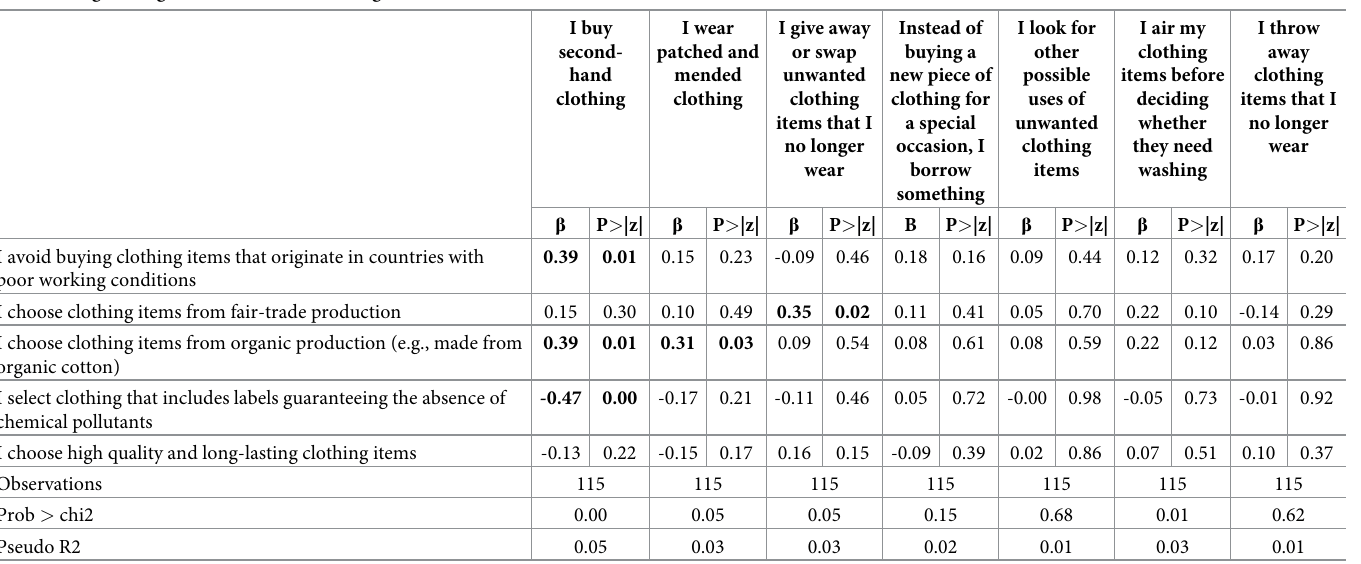
Table 5. Logistic regression of the centennial generation.